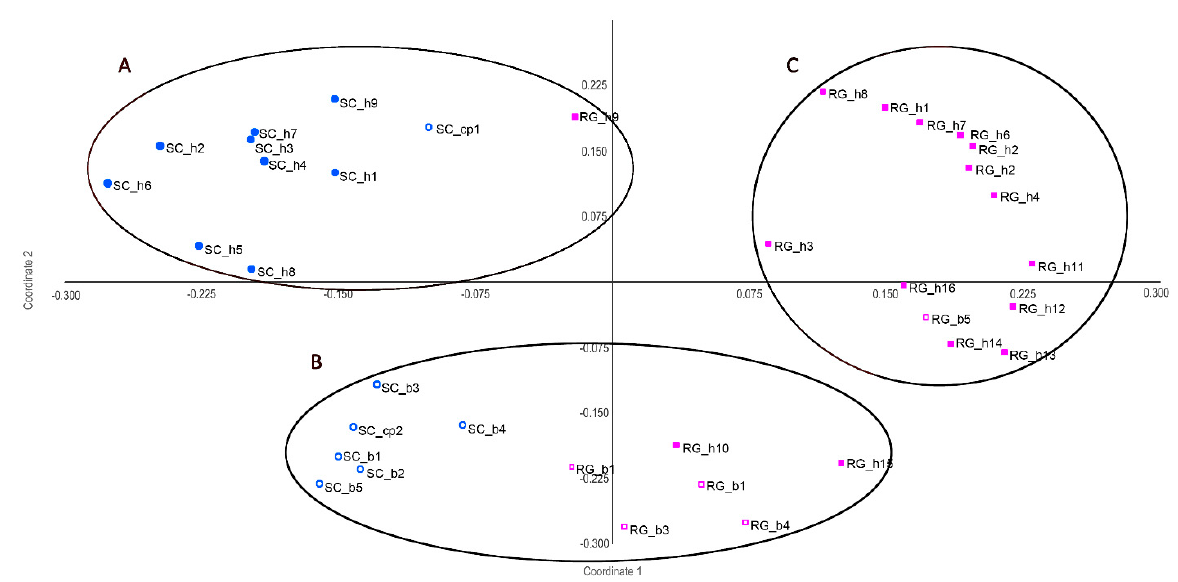
Figure 5. PCoA biplot on the incidence data of species recorded in Rio Gamberale and Stiffe Cave. Three groups are highlighted: ( A ) hyporheic sites of Stiffe cave; ( B ) benthic sites of both Rio Gamberale stream and Stiffe Cave; ( C ) hyporheic sites of Rio Gamberale stream. Abbreviations used: RG = Rio Gamberale stream; SC = Stiffe cave; RG_b = Rio Gamberale stream benthic site; RG_h = Rio Gamberale stream hyporheic site; SC_b = Stiffe Cave benthic site; SC_h = Stiffe Cave hyporheic site.